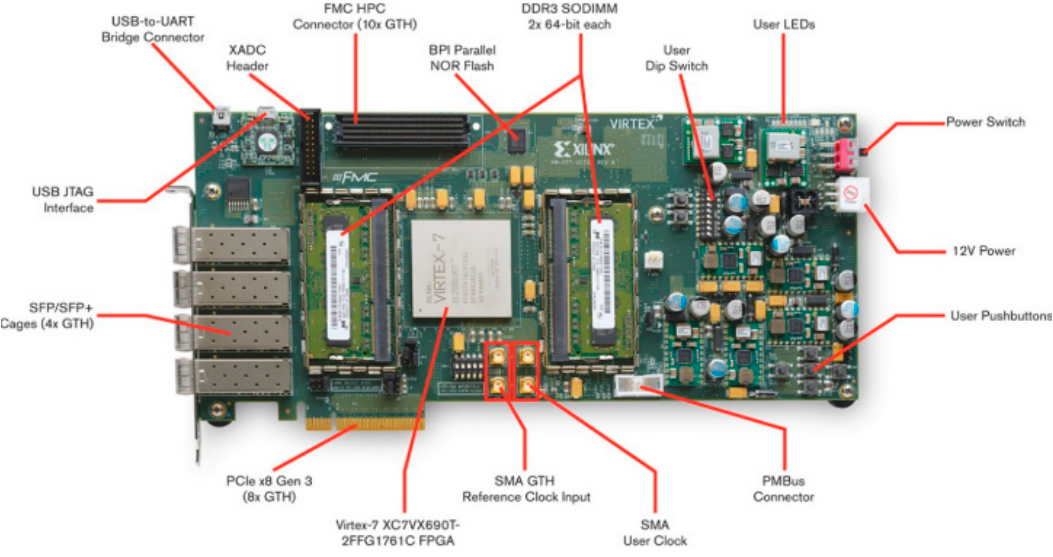
Figure 10. Virtex-7 Field - Programmable Gate Array (FPGA) VC709 development board.